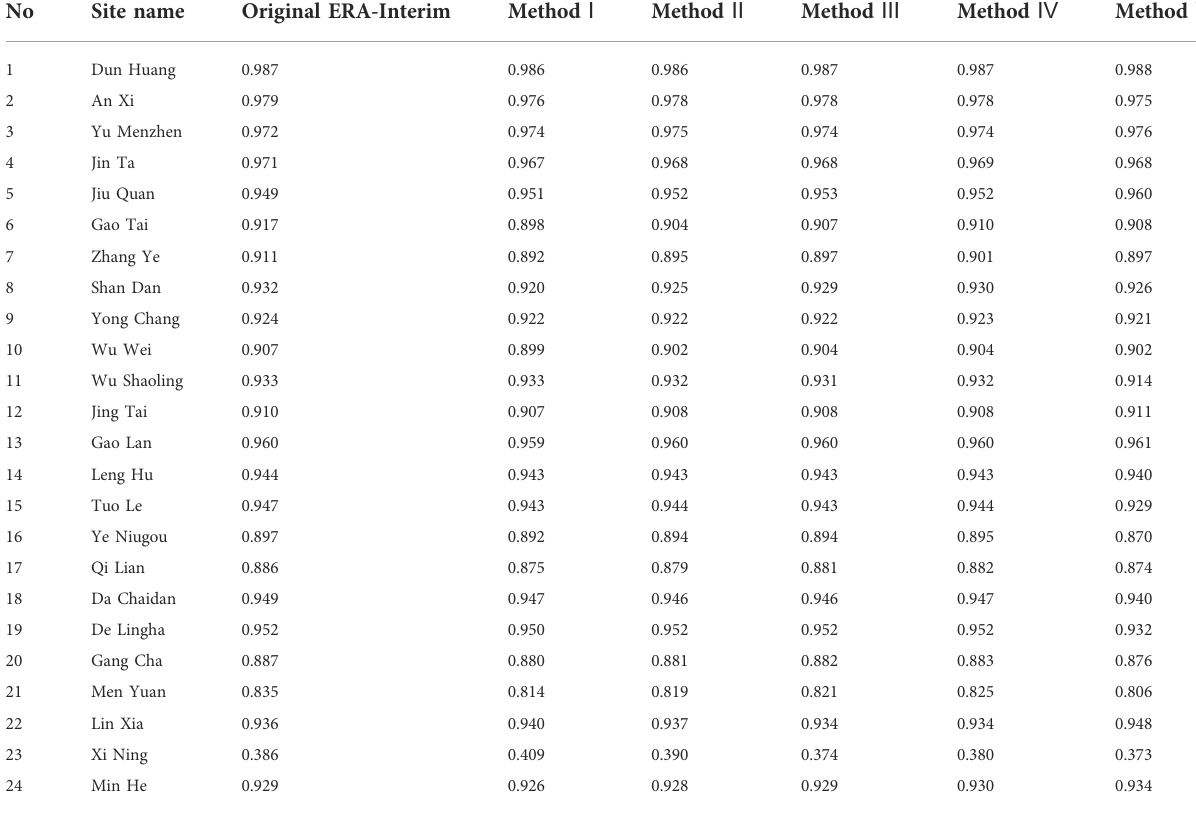
TABLE 6 Correlation coef fi cients ( r ) between daily observed and original ERA-Interim temperature, and between observed temperature and data obtained from fi ve correction methods for 24 meteorological stations during the period 1979 – 2017.